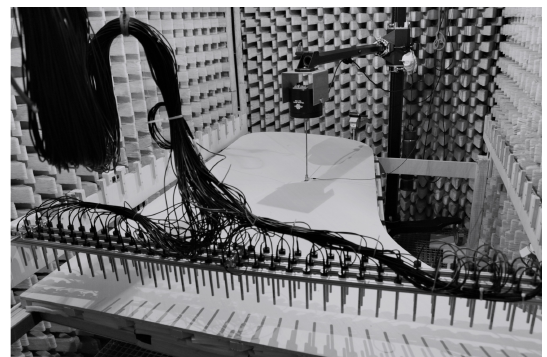
Figure 3. Measurement setup including a movable microphone array (in the front) above a soundboard, and an acoustic vibrator (in the rear) installed in an anechoic chamber. After the nearfield recordings parallel to the sound board, the microphone array samples the listening region of the instrumentalist in playing position.